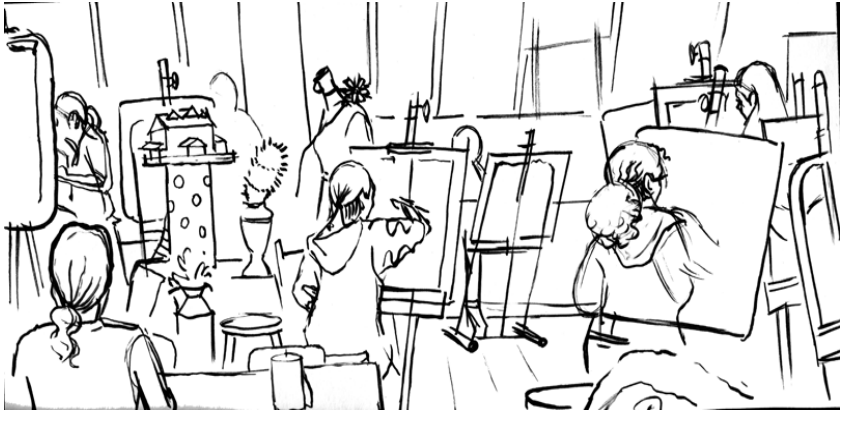
Figure 2. Drawing with the